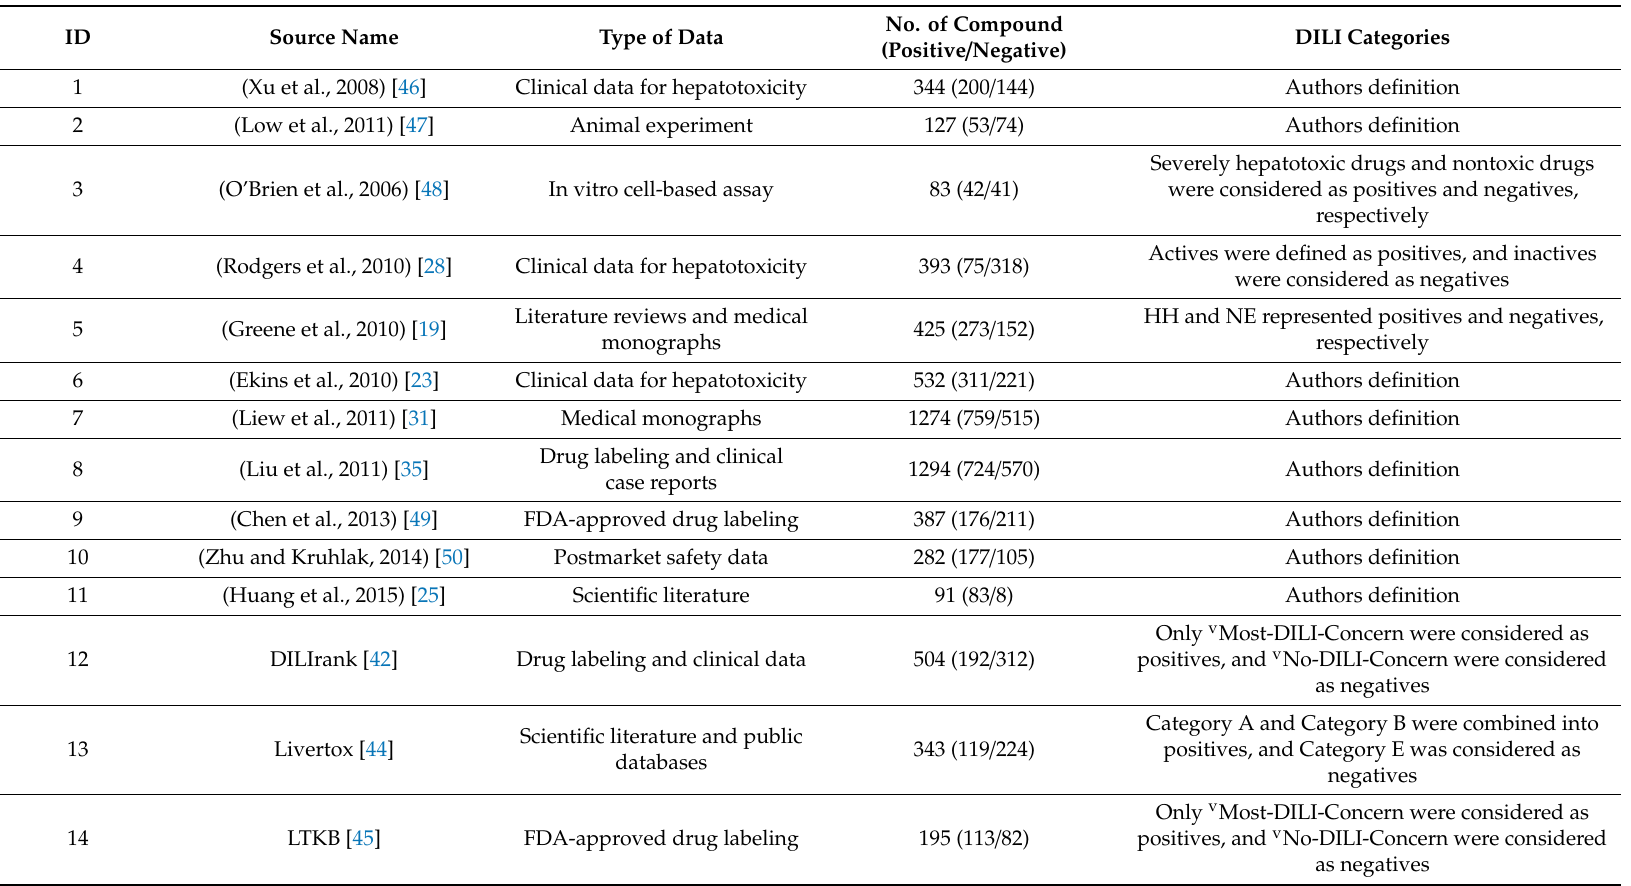
Table 3. Datasets of hepatotoxicity from prior